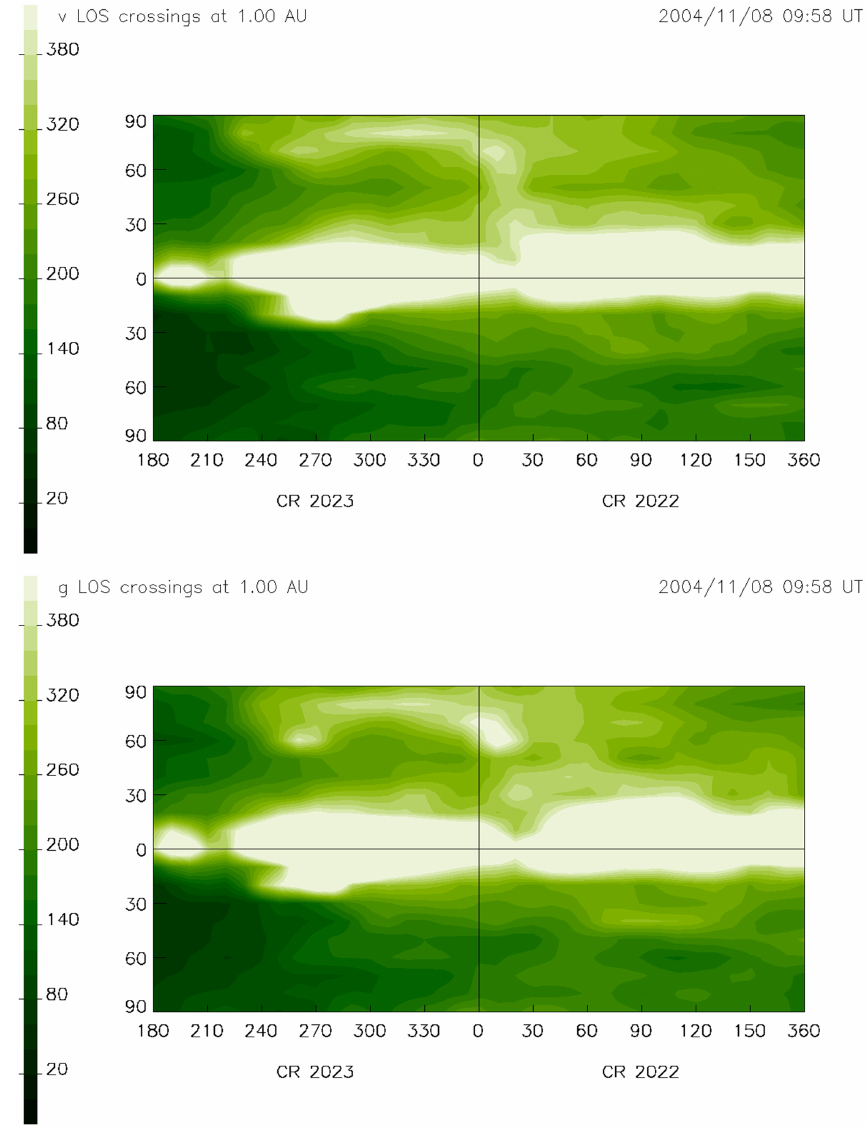
Fig. 6. As in Fig. 5 but at a height of 1AU from the Sun (more pertinent when comparing with L 1 -spacecraft in-situ measurements). As can be seen comparing these with Fig. 5, coverage is greater overall than at the source surface, particularly near the